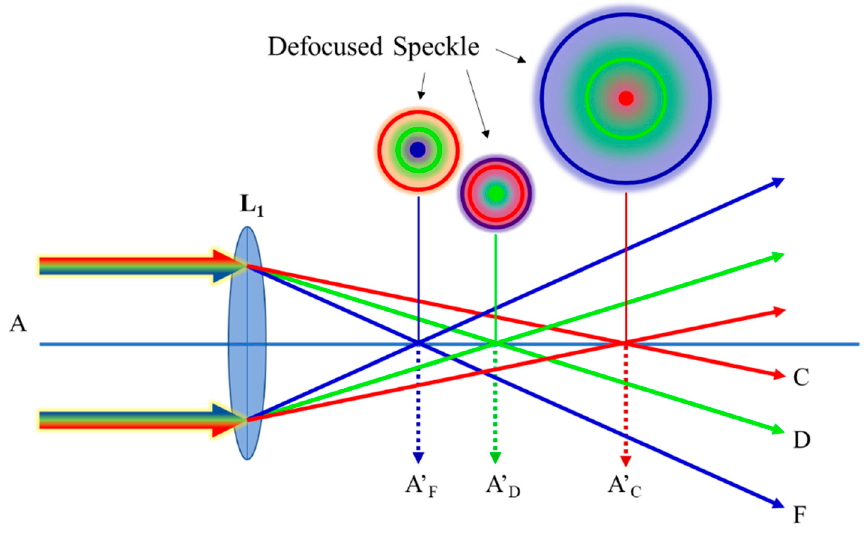
Figure 2. Schematic of chromatic aberration along the optical axis. A: object beam. Wavelengths of F, D, and C are 486 nm, 588 nm, and 656 nm,